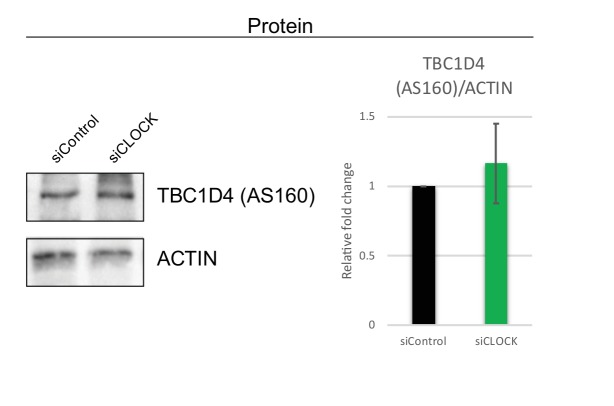
TBC1D4/AS160 protein levels are not affected by siCLOCK.Representative western blot for TBC1D4/AS160 in hSKM cells transfected with either siControl or siCLOCK for 72 hr. Quantification of TBC1D4/AS160 protein levels shows no statistically significant difference of upon CLOCK disruption. Data are mean ± SEM (N = 5, monoplicates).